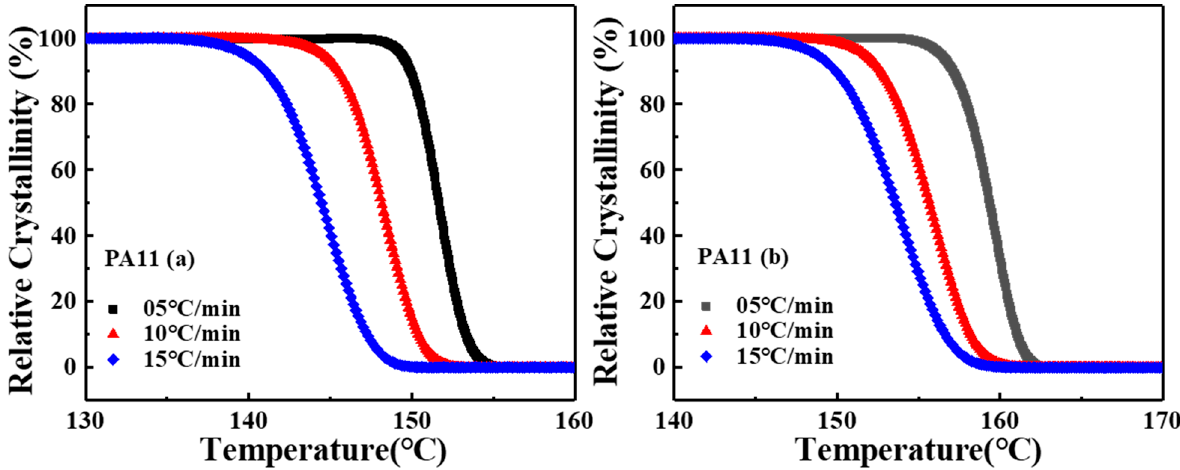
Figure 3. The relative degree of crystallinity versus temperature for non-isothermal crystallization of two PA11 specimens at various cooling rates.